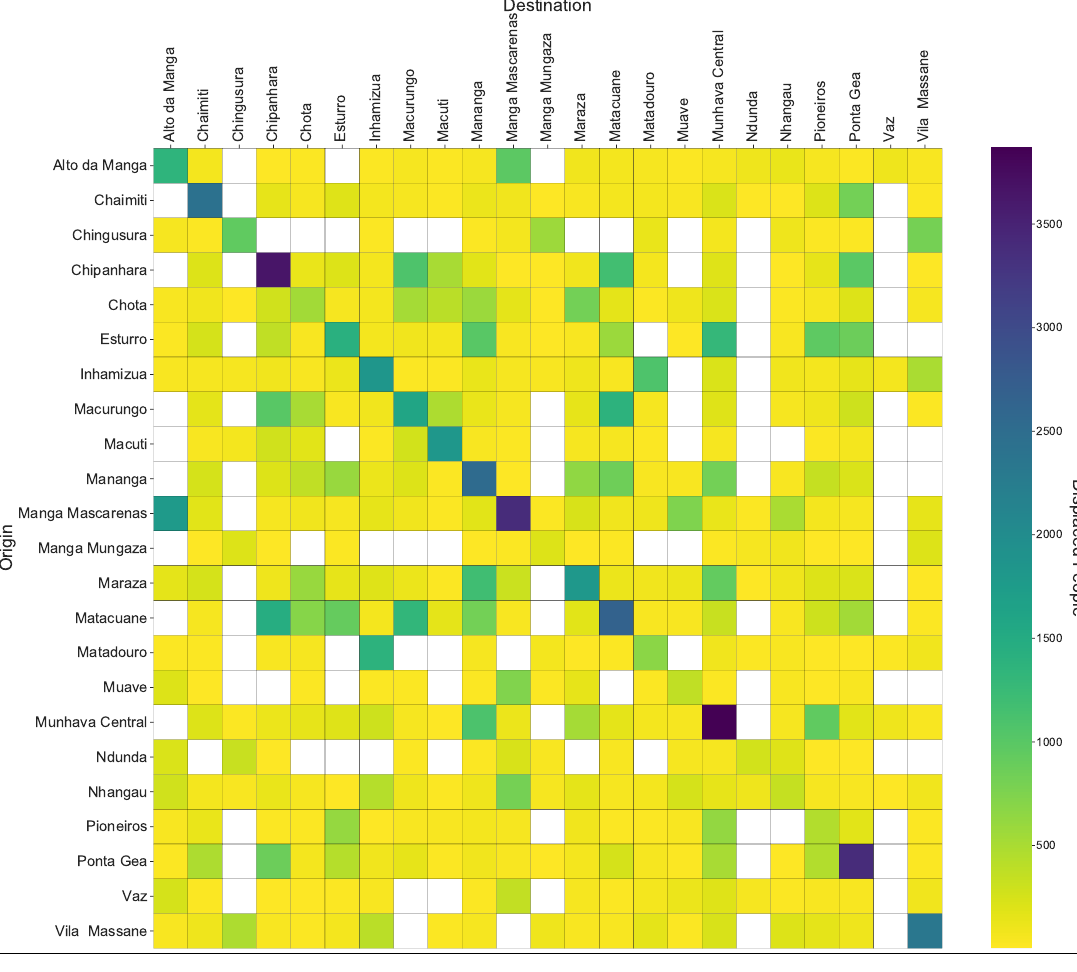
Figure 11. Actual population displacement